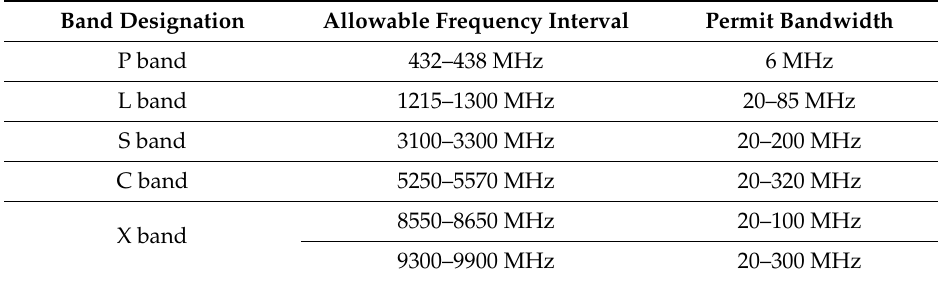
Table 1. Spectrum and bandwidth regulatory rules for space-borne active